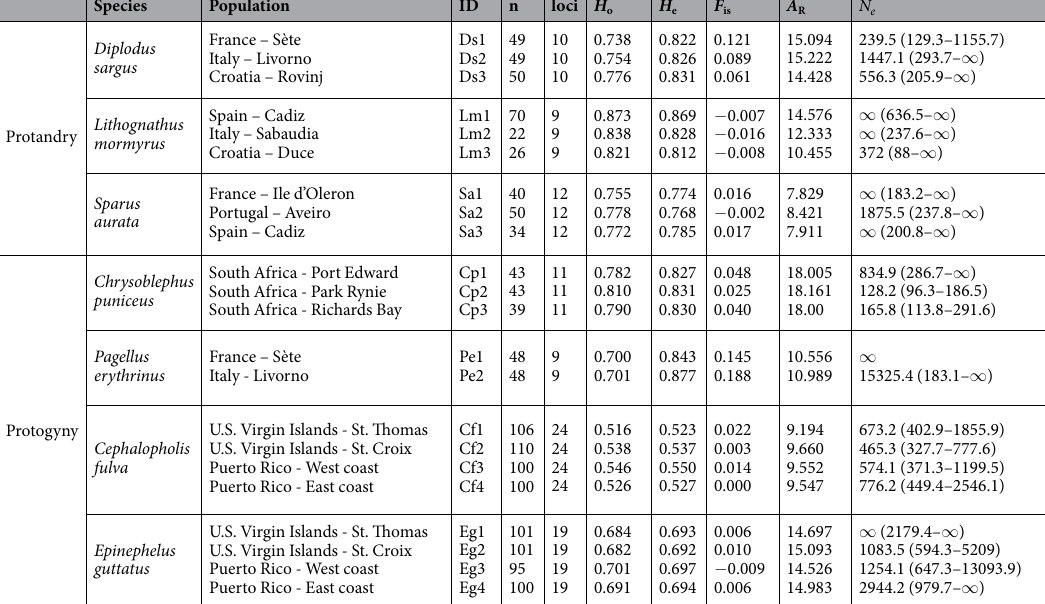
) estimated with e